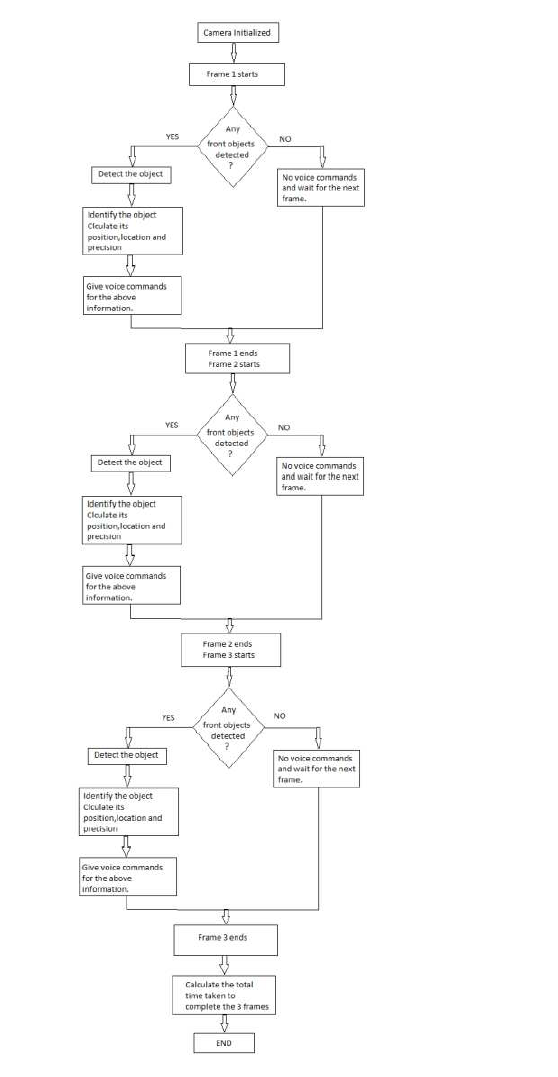
Figure 3 . Working Mechanism Flowchart